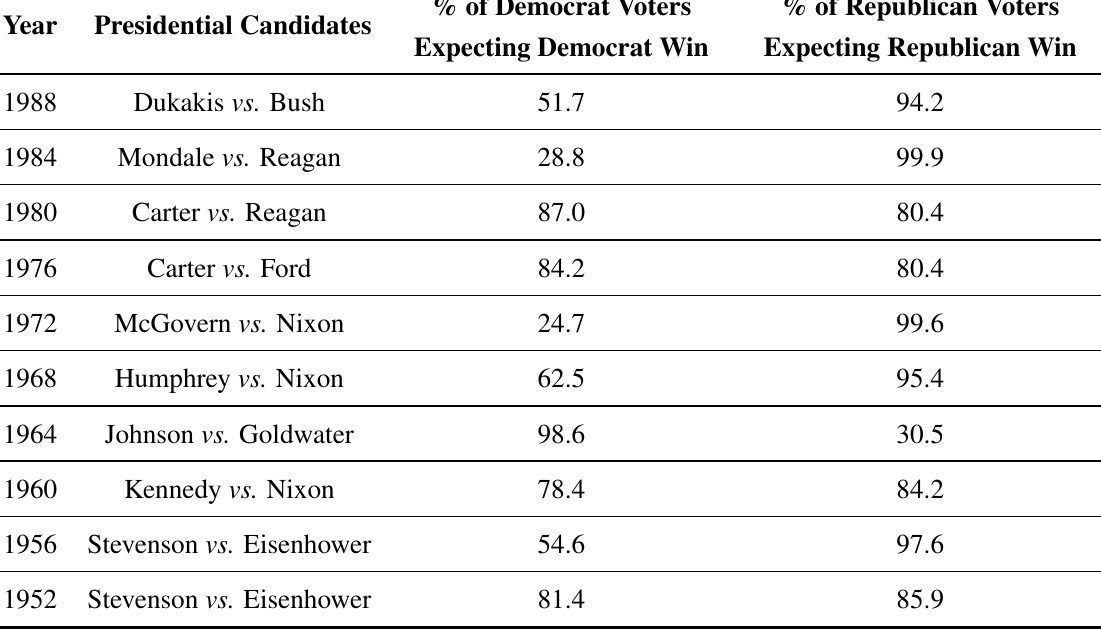
Table 3. US presidential elections. Source: Forsythe et al. ,